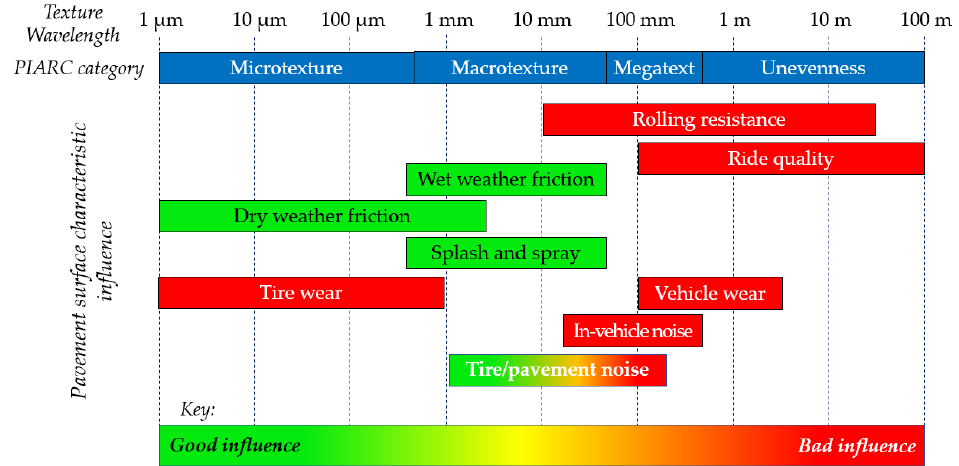
Figure 3. Texture wavelength range for each of the categories and their influence (safety, comfort, noise, wear, etc.) [32,33].